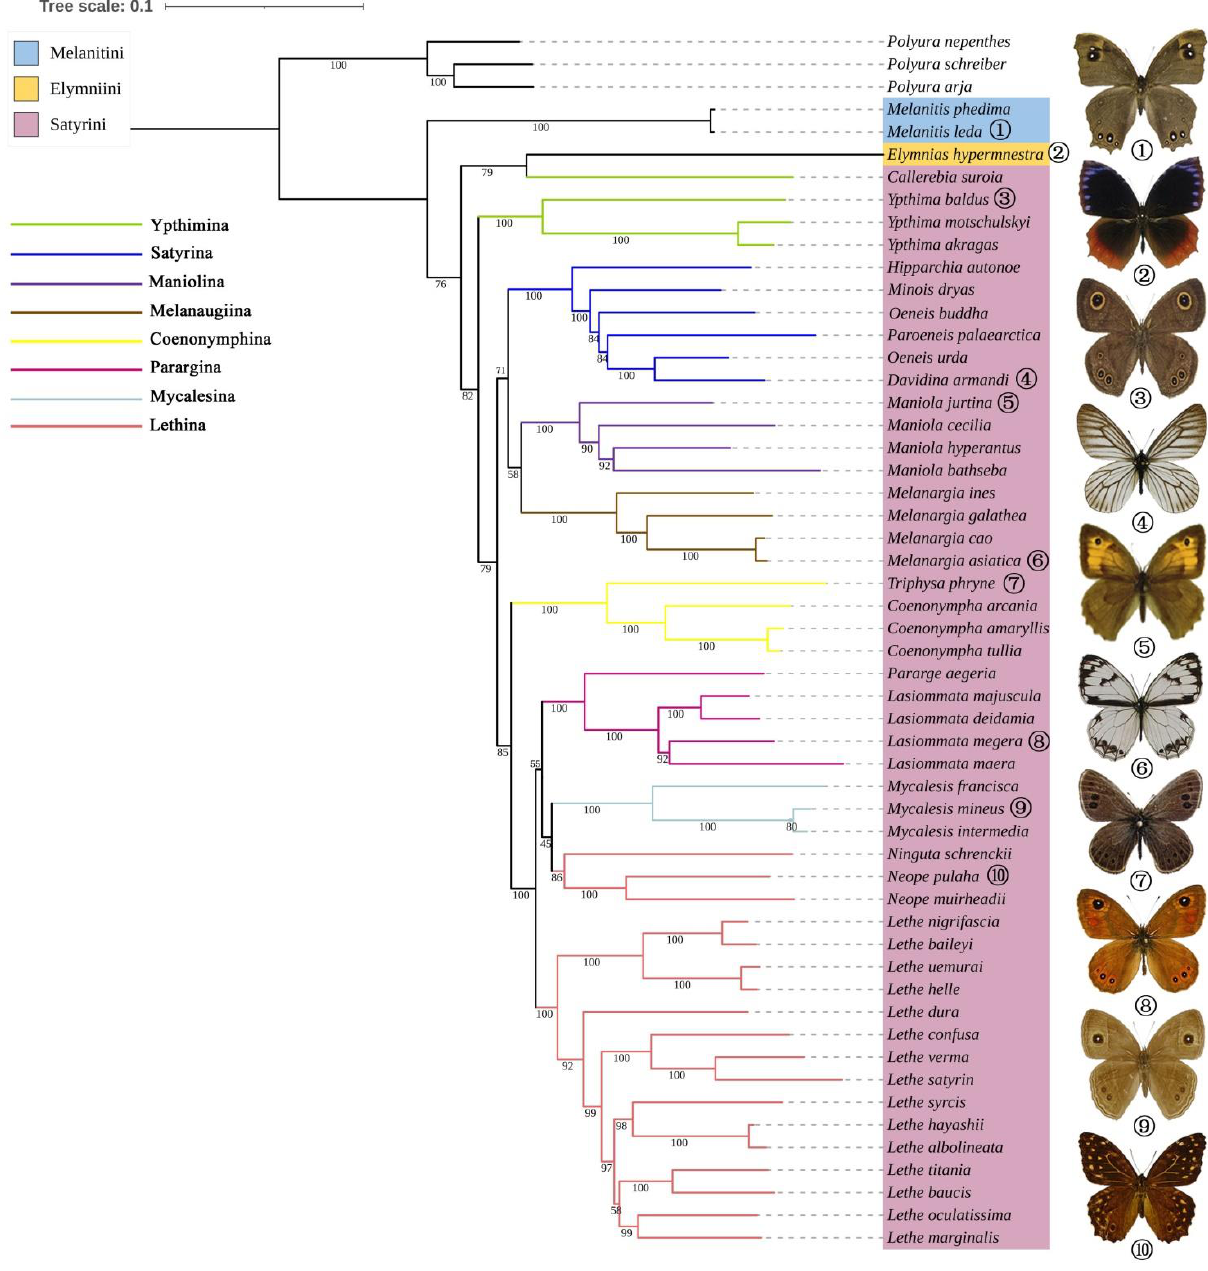
Figure 5. Phylogenetic tree inferred from nucleotide sequences of 13 PCGs and two rRNA genes using the ML. Bootstrap support values are indicated on branches.